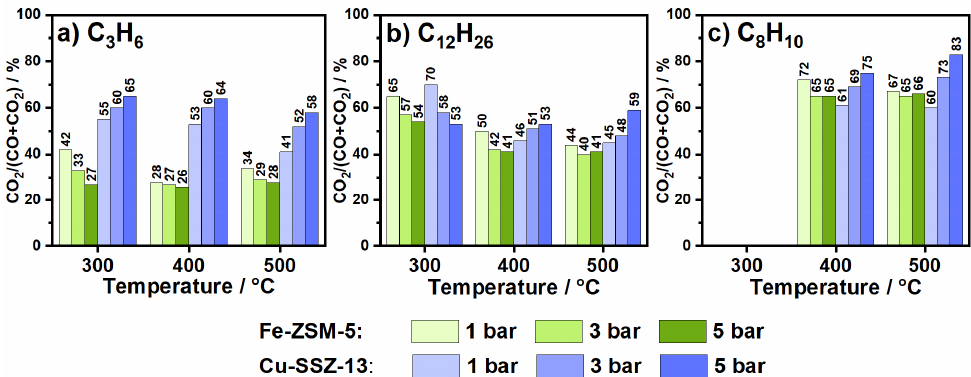
Figure 2. CO 2 proportion of formed CO x (CO + CO 2 ) during hydrocarbon oxidation of ( a ) 200 ppm C 3 H 6 , ( b ) 50 ppm C 12 H 26 and ( c ) 75 ppm C 8 H 10 in 14% O 2 , 4.5% H 2 O, N 2 over Fe-ZSM-5 and Cu-SSZ-13.